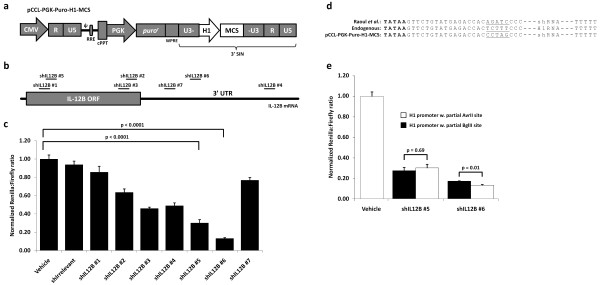
Development of a lentiviral vector for an easy one-step shRNA oligonucleotide cloning procedure and potency screening of a panel of shRNAs targeting human IL-12B. (a) Schematic overview of the lentiviral vector, pCCL-PGK-Puro-H1-MCS, for an easy one-step shRNA cloning procedure. shRNA oligonucleotides with compatible overhangs can be cloned into the multiple cloning site (MCS) from which shRNA expression will be driven by the H1 promoter. (b) Schematic overview of IL-12B mRNA and the target sites for the seven designed shRNAs. (c) Potency screening of seven shRNAs targeting IL-12B mRNA using the dual luciferase assay. HEK293 cells were co-transfected with the shRNA-encoding lentiviral vector and the psiCHECK-IL12B vector encoding firefly luciferase for transfection normalization and a fusion mRNA consisting of renilla luciferase and IL-12B. Luciferase activities were measured forty-eight hours post-transfection and renilla luciferase activity was normalized to firefly luciferase activity and depicted relative to transfection with the empty lentiviral vector, pCCL-PGK-Puro-H1-MCS, not encoding an shRNA (vehicle). (d) Sequence comparison of the 3' end of the H1 promoter depicting sequence differences introduced in the H1 promoter for cloning of shRNA oligonucleotides. The TATA box is depicted in bold, and sequence differences are underlined. Furthermore, the termination signal of the H1 promoter consists of 5 thymines. (e) Confirmation of full promoter activity from the H1 promoter of pCCL-PGK-Puro-H1-MCS modified to encompass a multiple cloning site for easy one-step cloning of shRNA oligonucleotides. shRNA potency was evaluated when expressed from the two sequence contexts of the H1 promoter, namely the context described by Raoul et. al. (black bars) and the new sequence context of the pCCL-PGK-Puro-H1-MCS (white bars). Comparison of shRNA potency was performed using the dual luciferase assay as described above. All dual luciferase assay experiments were performed at least in triplicates and data are depicted as mean + SEM.